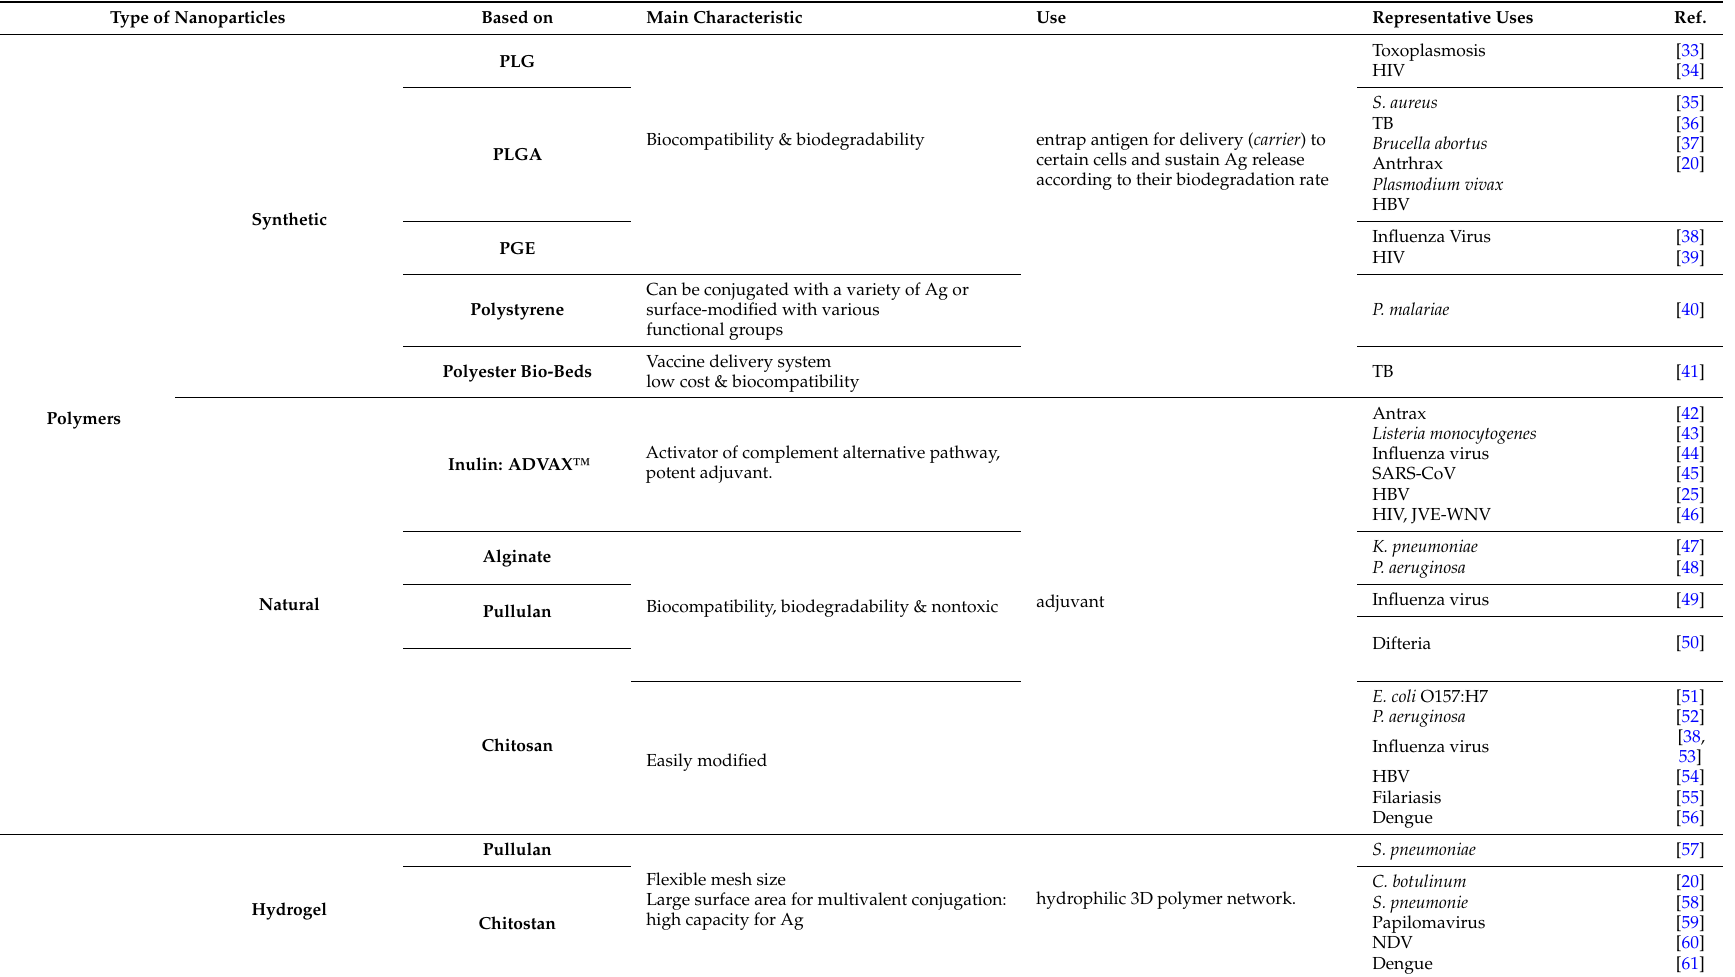
Table 1. Most representative vaccine applications based on